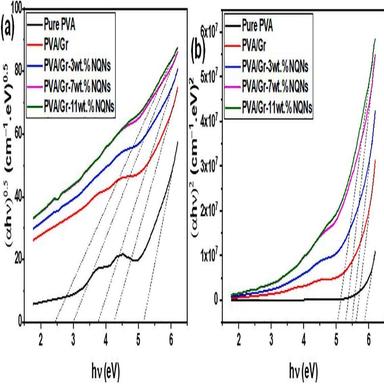
Tauc plots for estimating the optical bandgap energy of pure PVA and the fabricated PNCs (PVA/Gr, PVA/Gr-3 wt% NQNs, PVA/Gr-7 wt% NQNs, and PVA/ Gr-11 wt% NQNs) for (a) Eig and (b) Edg.